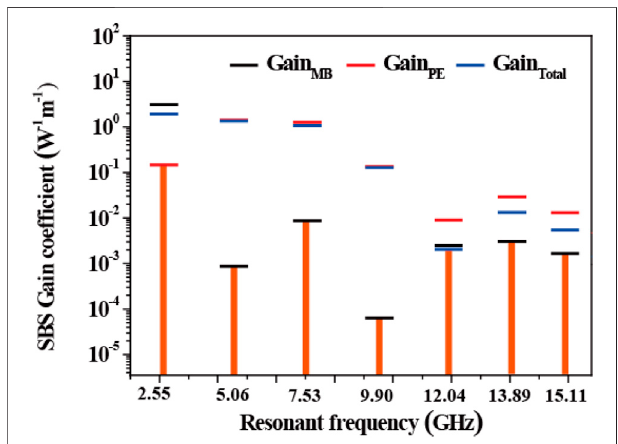
FIGURE4| ThecontributionofdifferenteffectstoSBSgaincoef fi cientin the process of stimulated Brillouin scattering when waveguide width w (cid:1) 1,750 nm, including the contribution of moving boundary effect (black short line),radiationpressureeffect(redshortline),andthewholeBrillouingain (blue short